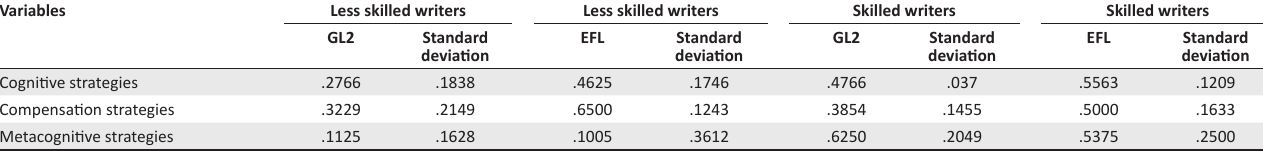
TABLE 4: Differences between skilled and less-skilled writers in cognitive, compensation and metacognitive strategies. Variables